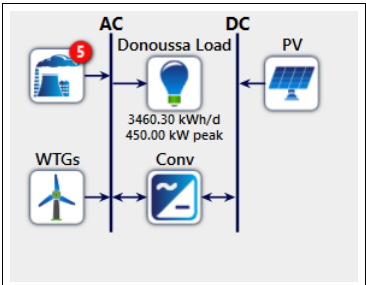
Figure 5. Scenario 1 Homer Pro Configuration.